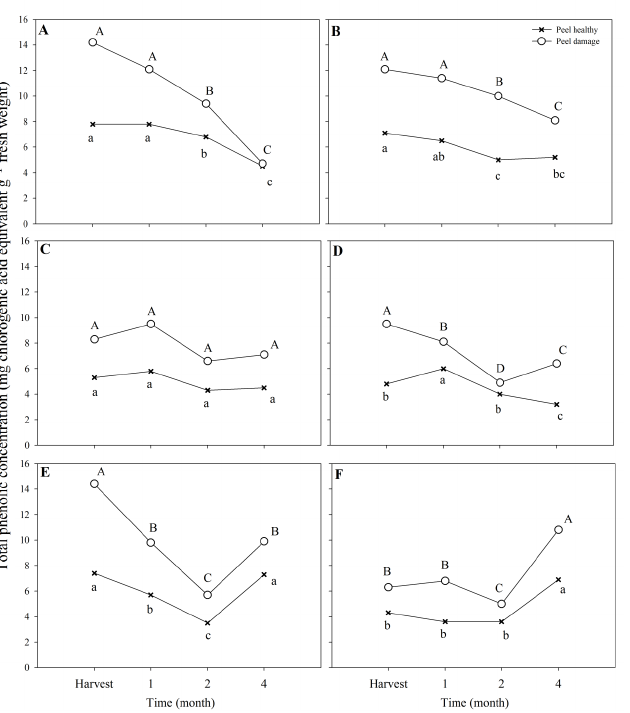
Fig. 2: Evolution of total phenolic compounds in apple peel with sun- burned and healthy, from cv. Brookfield ® (A and B), Granny Smith (C and D) and Fuji (E and F) of conventional (A, C and E) and or- ganic (B, D and F) orchard, from harvest to 4 months of cold